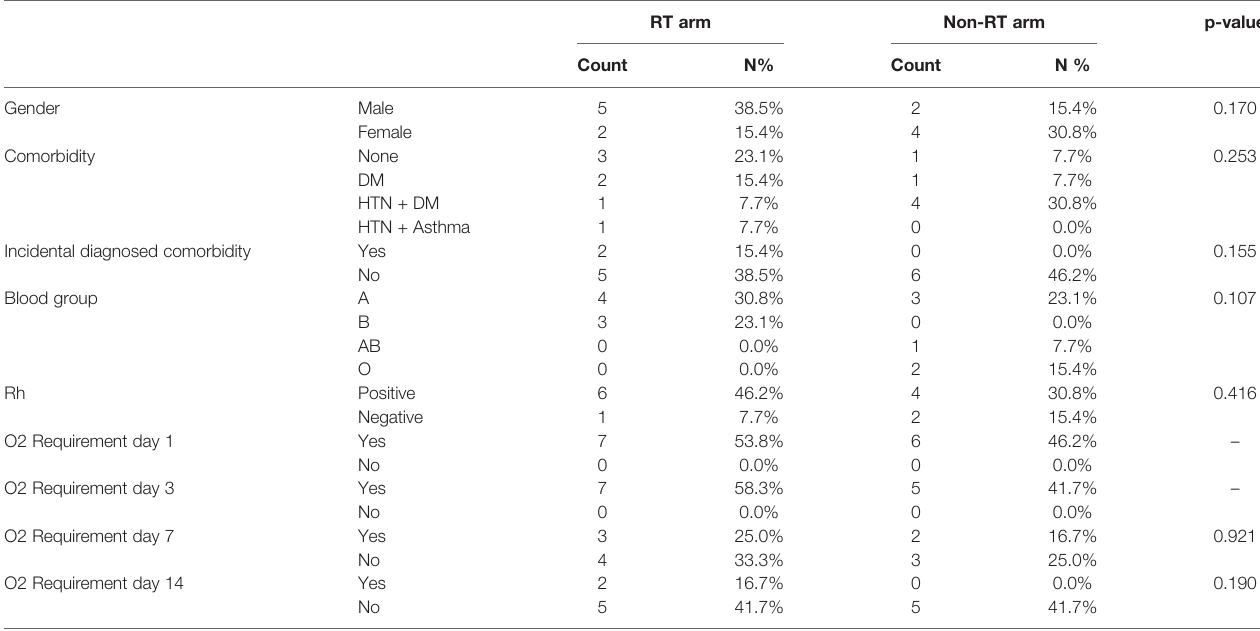
TABLE 1 | Clinical characteristics of patients during admission and hospital stay.